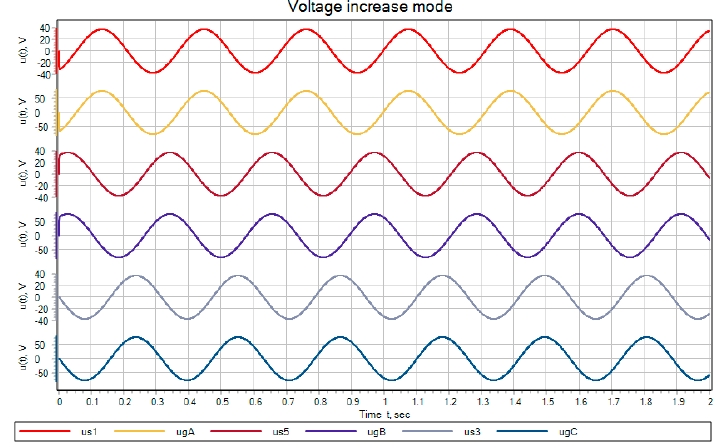
Figure 27. On-load voltage with the stator windings connected in series.